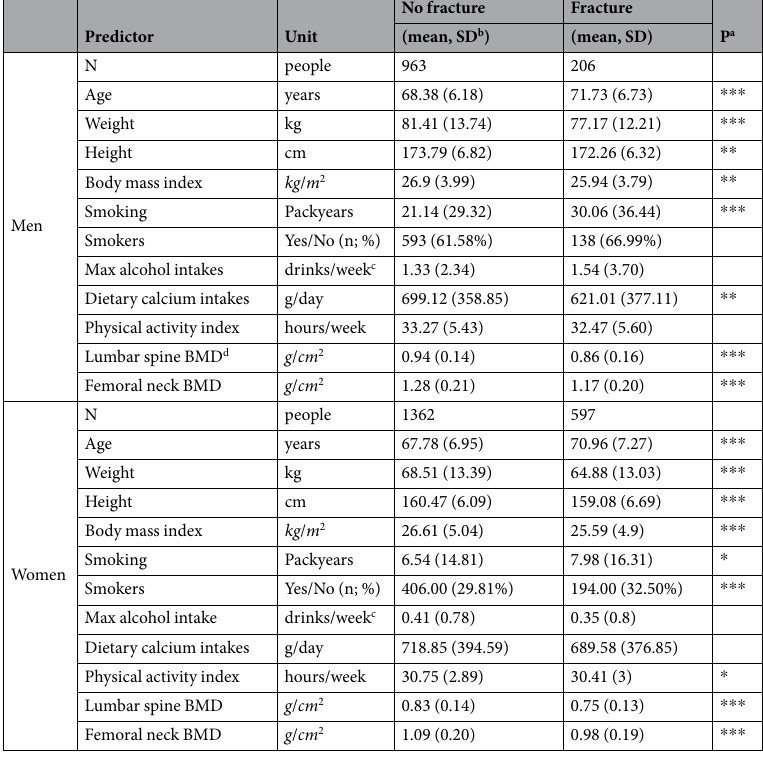
Table 1. Characteristics of individuals (baseline). a Significane codes: ‘ *** ’ is < 0.001; ‘ ** ’ 0.01; ‘ * ’ 0.05; ‘.’ 0.1; ‘’ > 0:1. b SD: standard deviation. c Alcohol consumption intakes were assessed by standard drinks per week. 1 standard drink = a glass of wine or a middie of beer or a nip of spirits. d BMD: Bone mineral